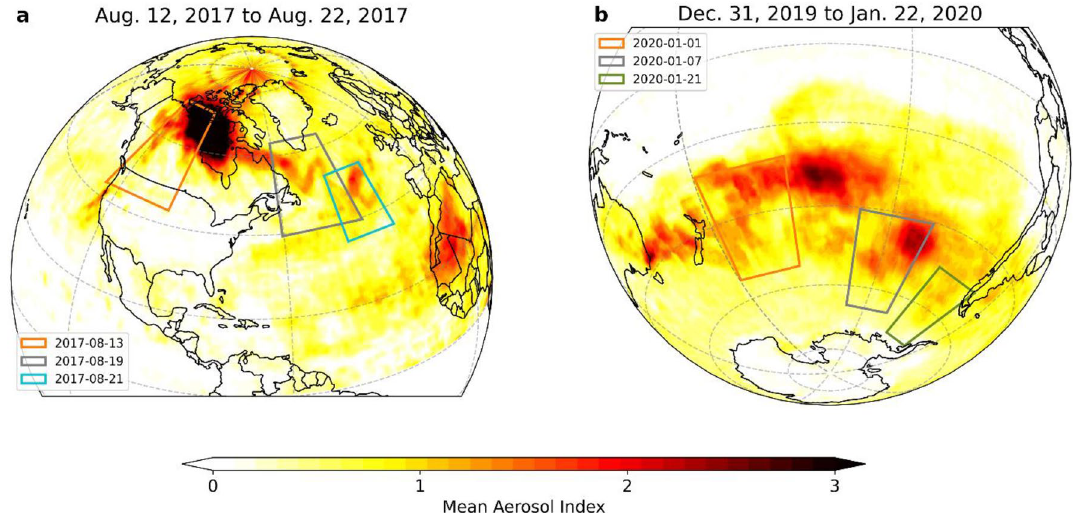
Figure 1. Regions affected by the Northern American and Australian wildfire plumes. ( a ) Mean aerosol index (AI) for the 2017 North American wildfire event between August 12 and 22 and ( b ) the AI between December 31 and January 22 for the 2019/20 Australian wildfire event. Colored rectangles show the area surveyed on the respective days. AI values are plotted for the respective hemisphere where the event occurred. Note that the large AI values measured in the central Pacific did not reach stratospheric